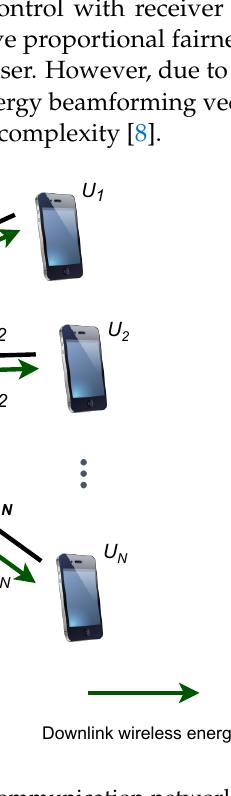
Figure 1. A wireless powered communication network (WPCN) : the base station with a hybrid access point (H-AP) , equipped with multiple antennae, and the N receivers each have a single antenna. Wireless energy is transferred from the H-AP to the N users on downlink, and mobile users transmit information to the H-AP on